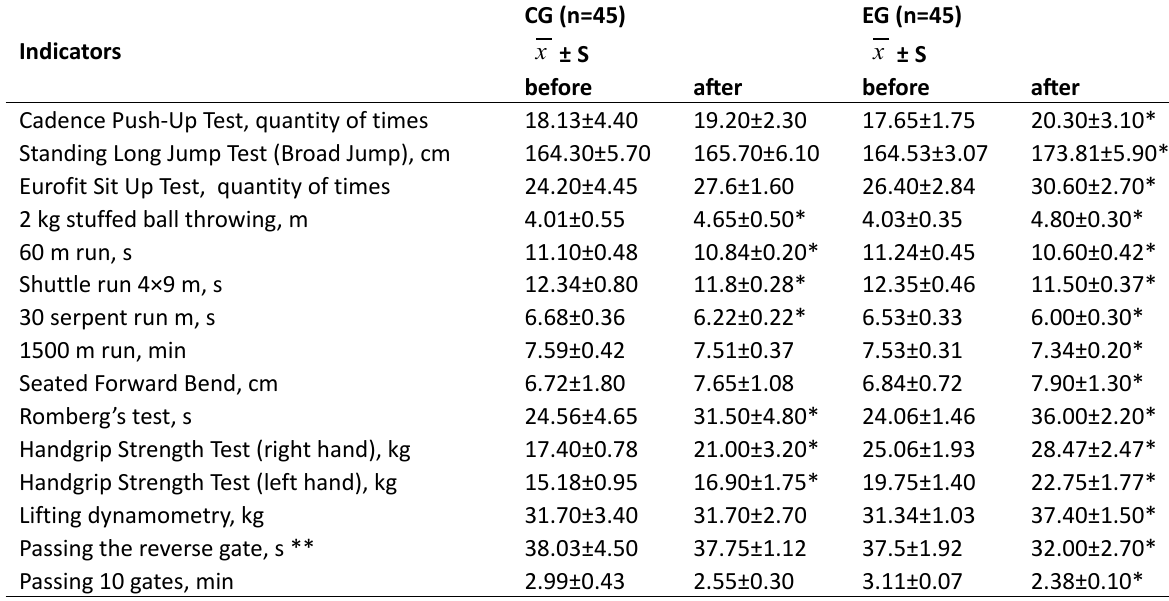
Table 1. Indicators of physical fitness of 12-13 years athletes before and after the experiment